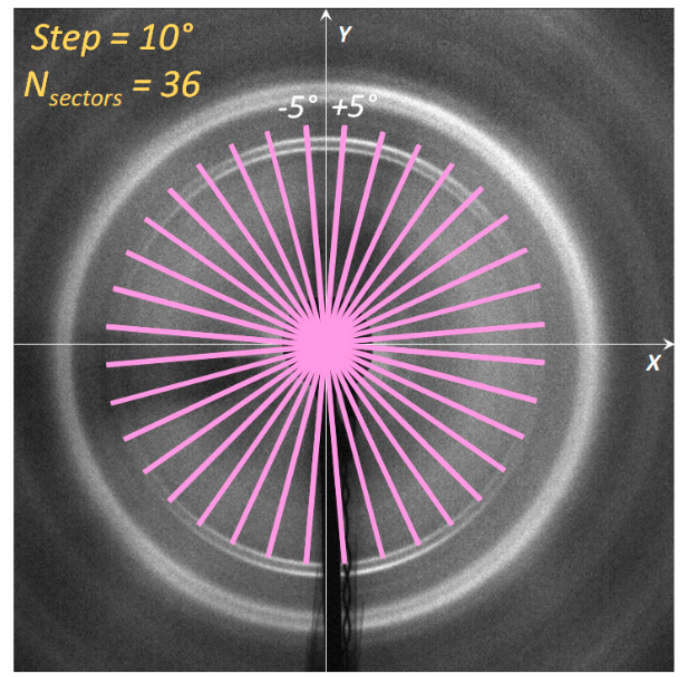
Figure 4. Illustration of the ‘caking’ procedure for the conversion of 2D diffraction pattern to a set of 1D ‘radial’ intensity distributions.